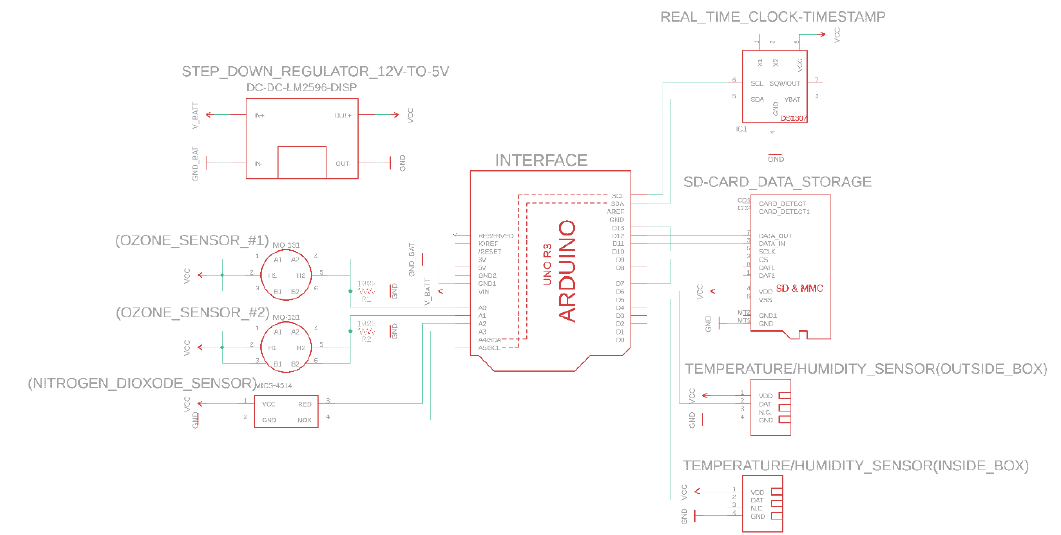
Figure 1. Schematics for the low-cost equipment—battery or AC/DC adapter powered (grid).